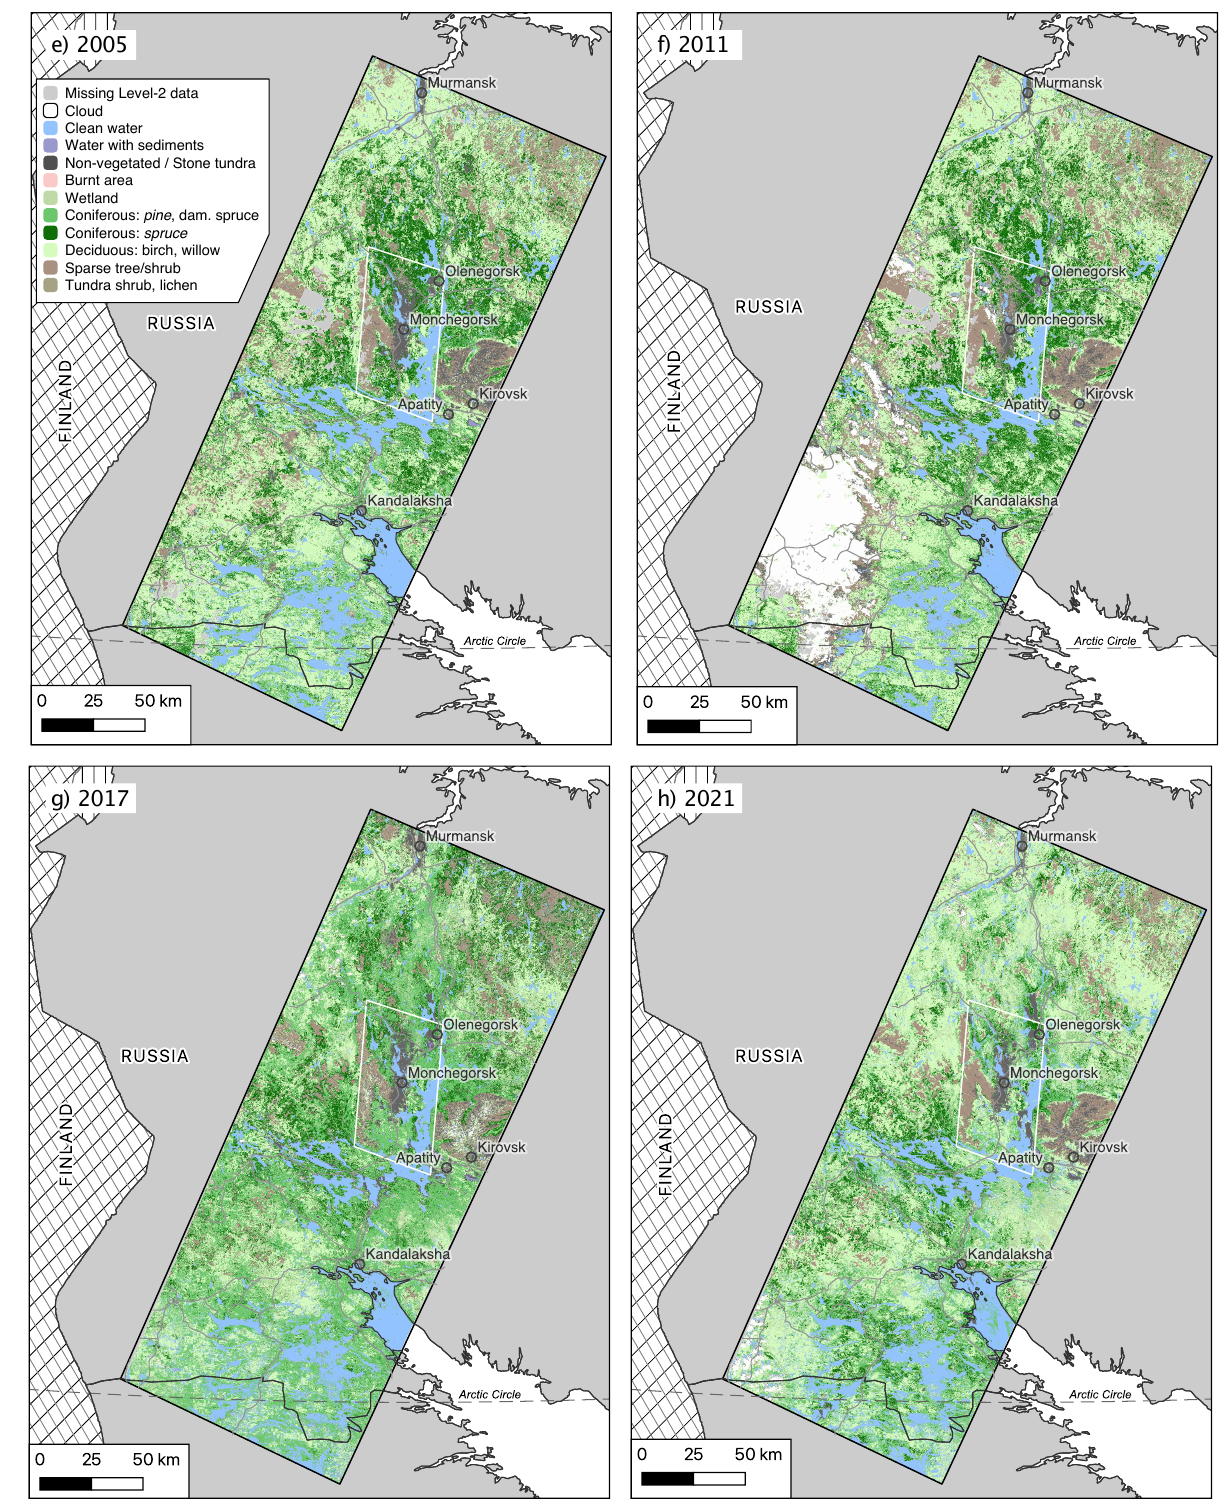
Figure 8. Land cover classification for years ( a ) 1985, ( b ) 1990, ( c ) 1996, ( d ) 1999, ( e ) 2005, ( f ) 2011, ( g ) 2017 and ( h ) 2021 for the boreal forest zone, Kola peninsula, Russia. The white quadrilateral indicates the area close to Monchegorsk suffering most from industrial development and industrial pollution. Full legend is given in Table